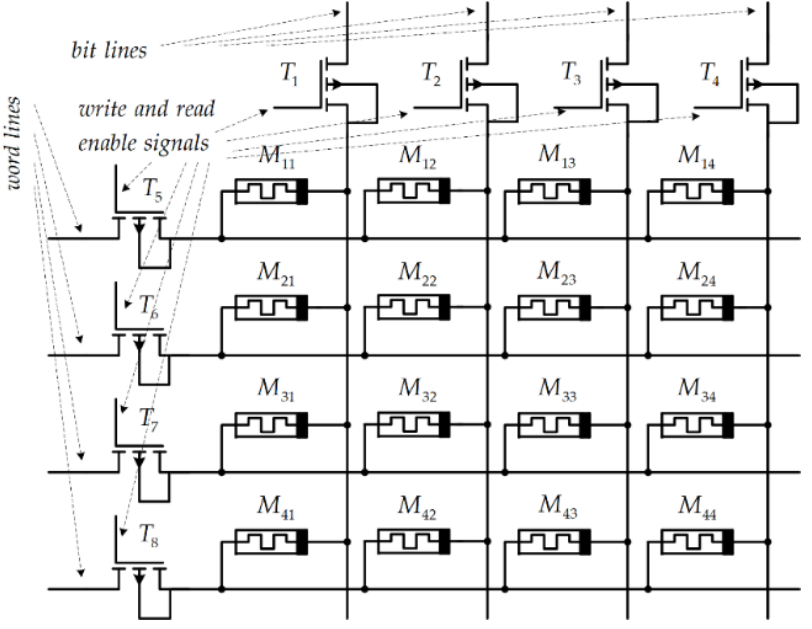
Figure 5. A hybrid memristor memory crossbar.